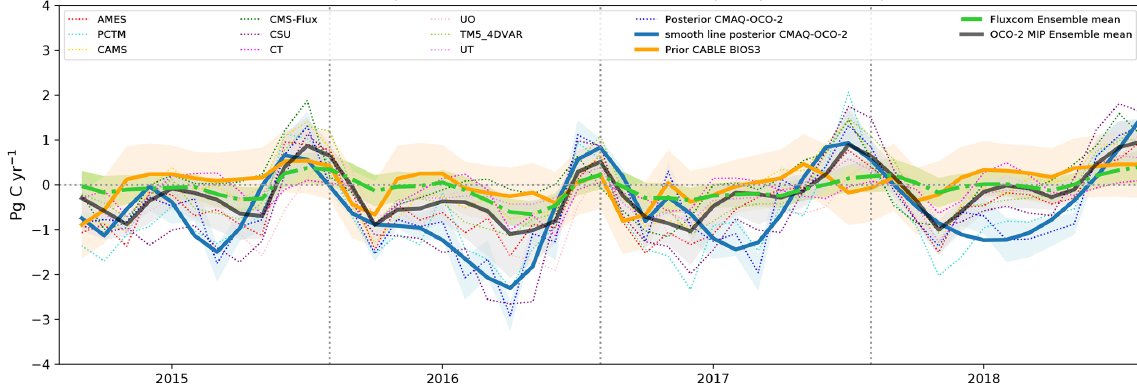
Figure 13. Comparison between 3-month running mean posterior (black line), prior (grey orange), FLUXCOM ensemble, OCO-2 MIP ensemble carbon flux anomalies, and 3-month running mean anomalies of the nine models that participate in OCO-2 MIP: AMES, PCTM, CAMS, CMS-Flux, CSU, CT, OU, TM5-4DVAR, and UT (in PgCyr − 1